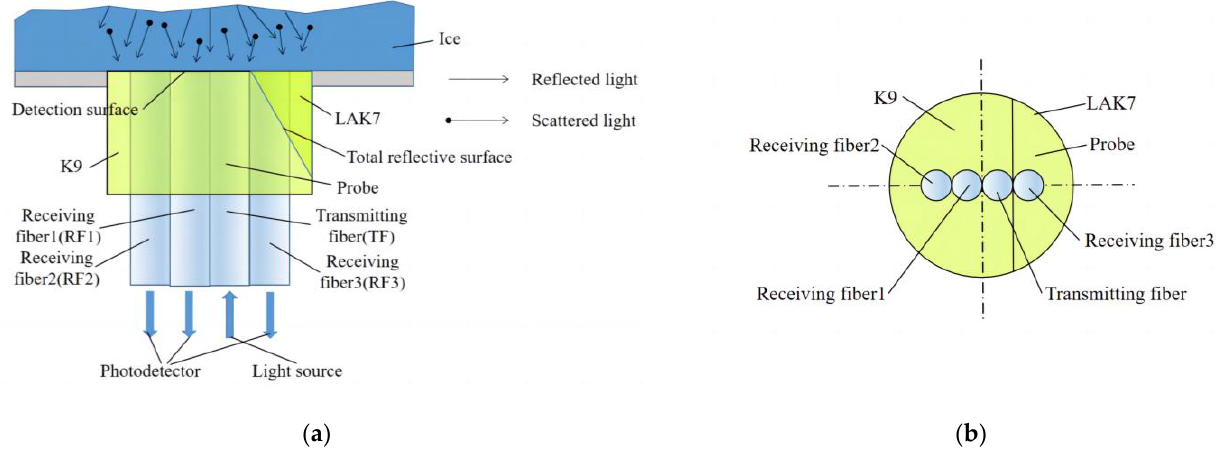
Figure 1. Schematic diagram of fiber-optic ice sensor structure. ( a ) Schematic diagram of the structure; ( b ) fiber arrangement